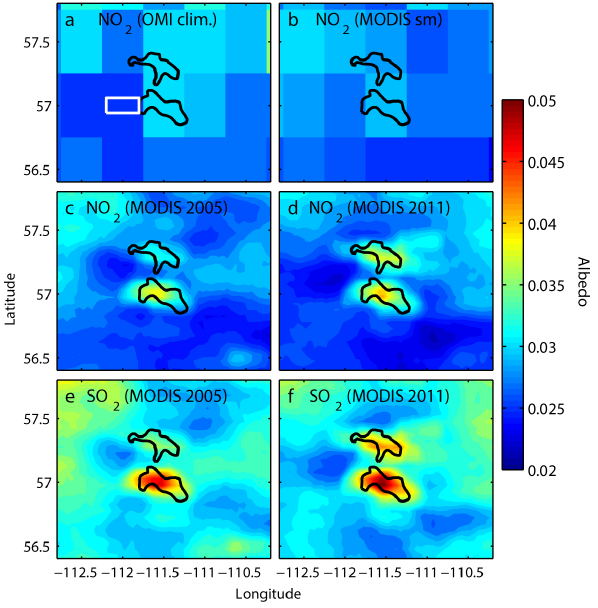
Fig. 3. Comparison of mean summer (JJA) surface albedos: (a) OMI climatological albedo at 442nm (Kleipool et al., 2007), (b) MODIS albedo for 2005 from Eq. (4) for NO 2 (477nm but scaled to 442nm) and smoothed to the resolution of the OMI climatology, (c) MODIS albedo for 2005 from Eq. (4) for NO 2 (477nm but scaled to 442nm), (d) the same as (c) but for 2011, (d) MODIS albedo for 2005 from Eq. (4) for SO 2 (477nm but scaled to 354nm), and (f) the same as (e) but for 2011. Each map shows the approximate outline of the surface mining region. The white rectangle in panel (a) also represents the approximate size of an OMI